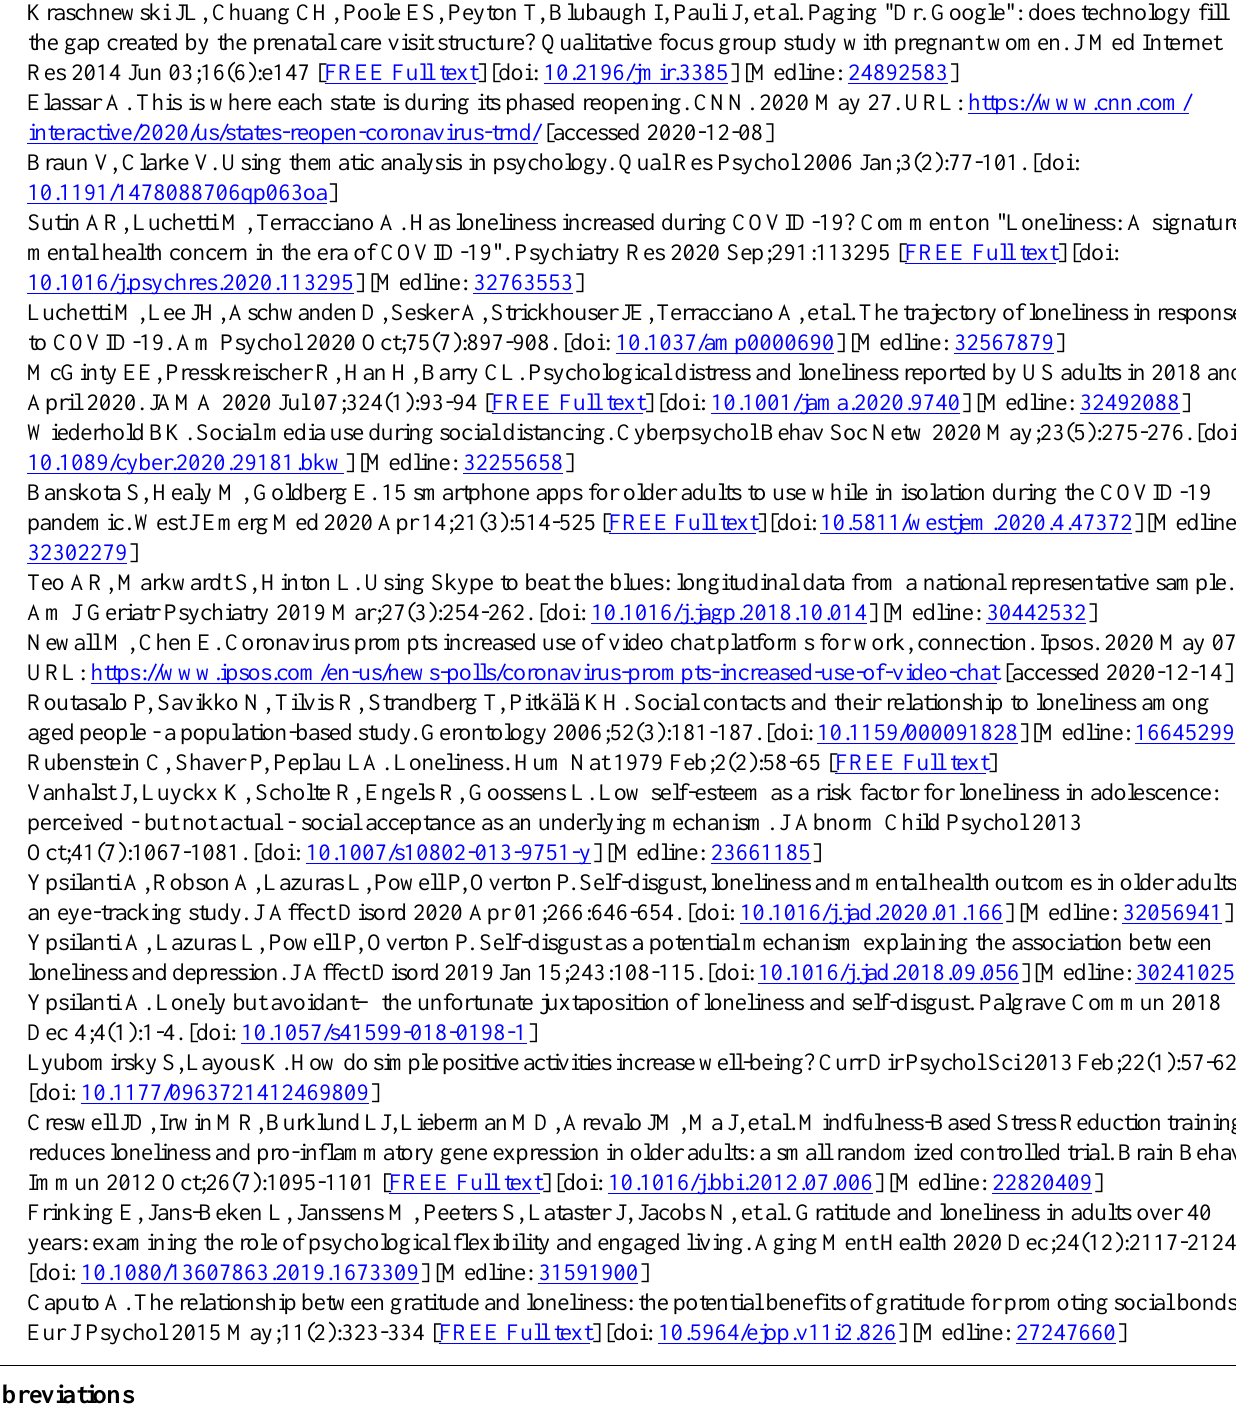
RCT: randomized controlled